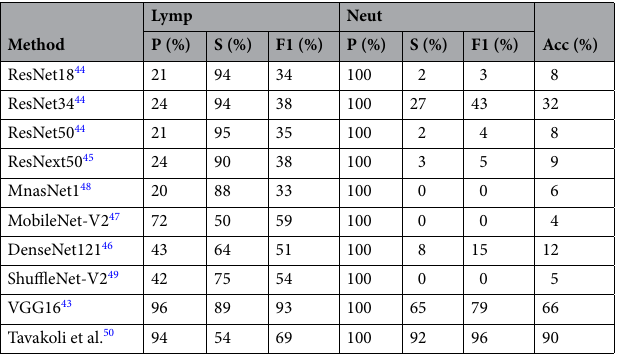
Table 9. The results of different pre-trained models as well as Tavakoli et al. 50 on the test-B dataset.